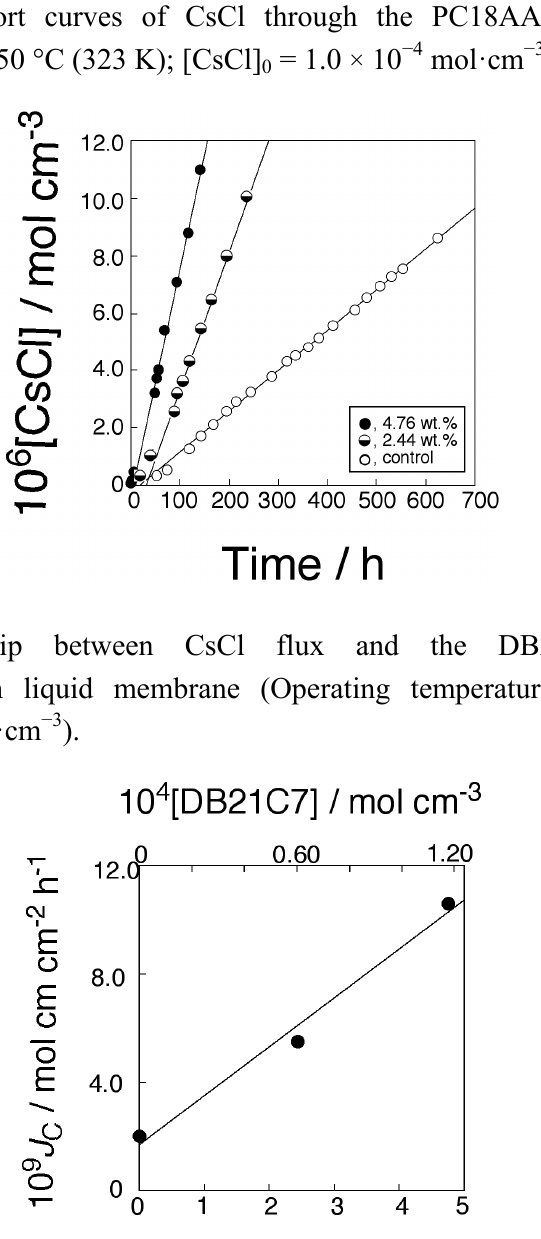
Figure 8. Time-transport curves of CsCl through the PC18AAm liquid membrane